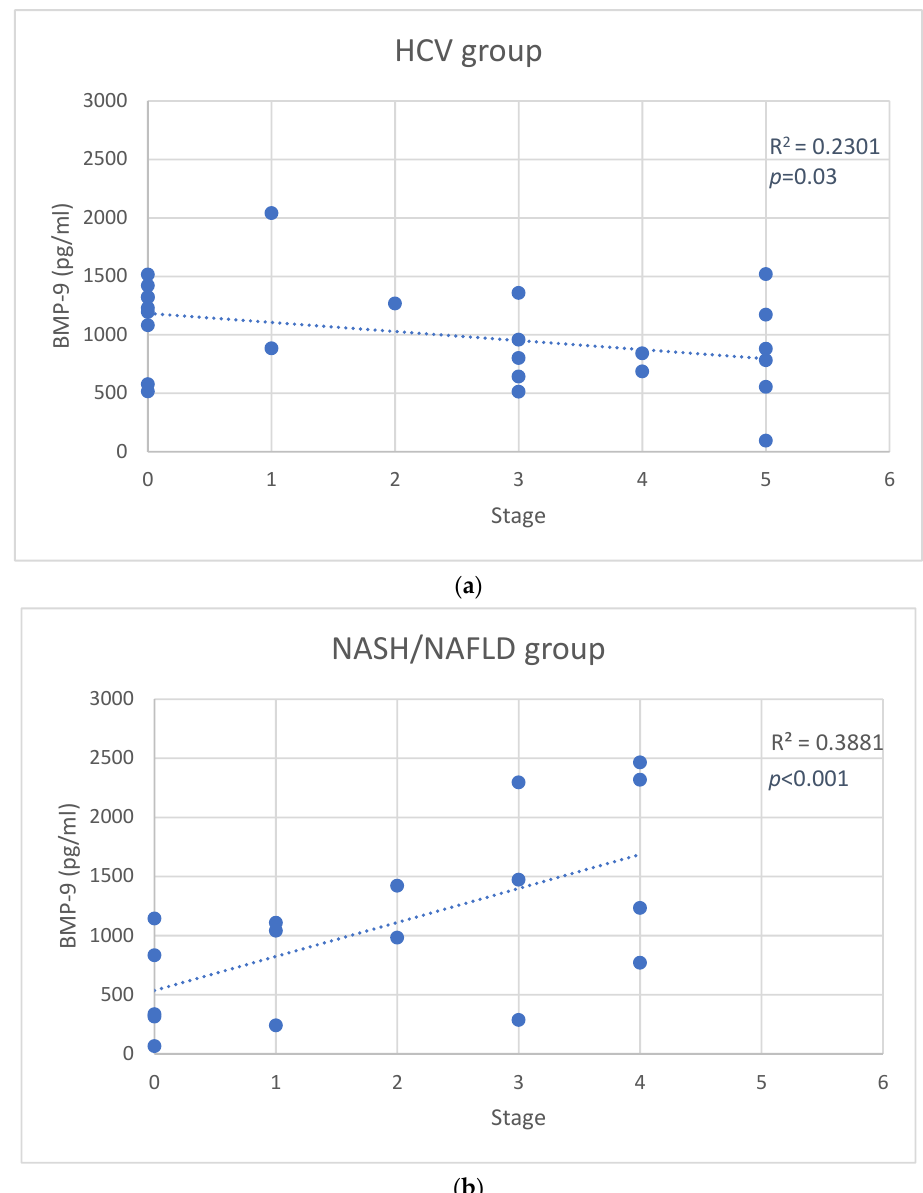
Figure 1. Scatter plot of hepatocyte growth factor (HGF) changes versus stage in the hepatitis C vi- rus (HCV) group ( a ), and in the nonalcoholic steatohepatitis (NASH)/nonalcoholic fatty liver dis- ease (NAFLD) group ( b ). Solid lines represent the linear fit of data.